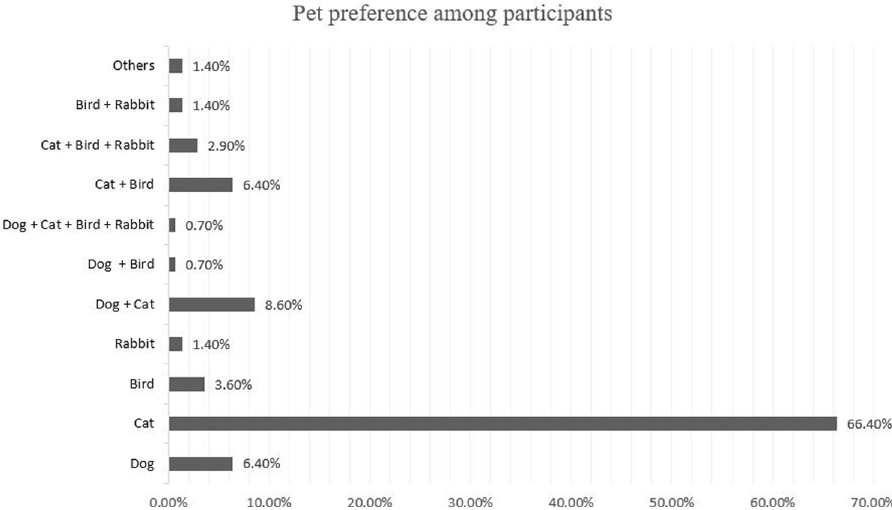
Figure 1. Pet ownership vs pet preferences.